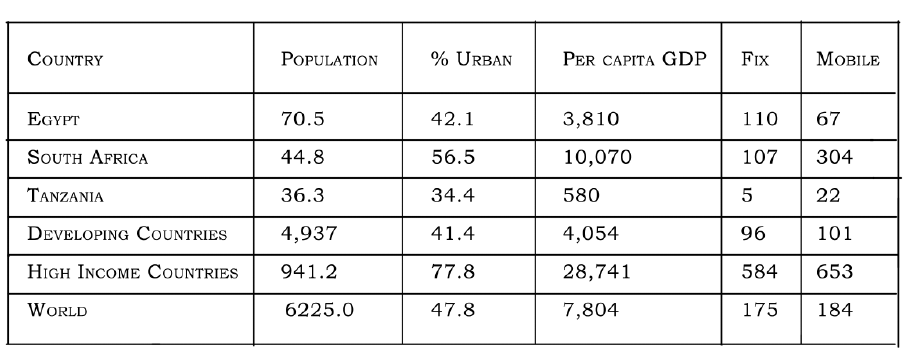
Table 1. Fixed lines and mobile lines per 1000